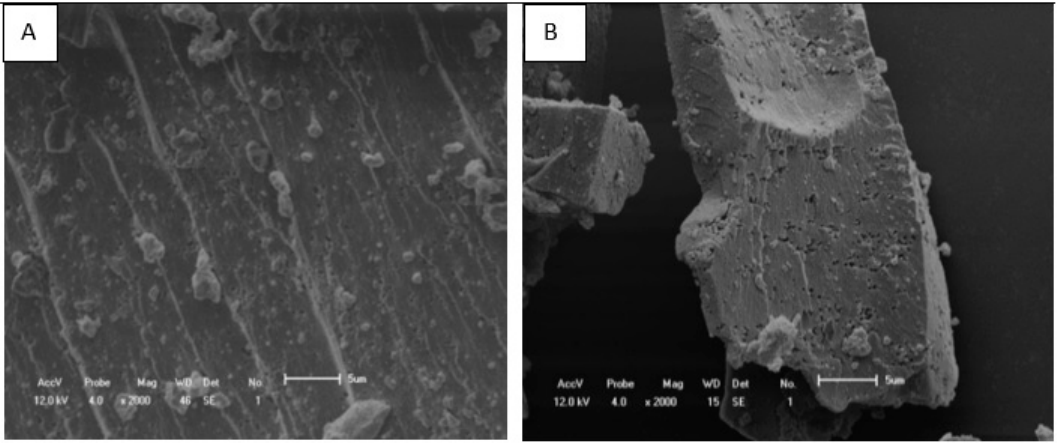
Figure 4. Scanning Electron Microscopy Images for CS ( A ) and CSP ( B ). The images are 5 micrometers with zoom of 2000×, respectively.